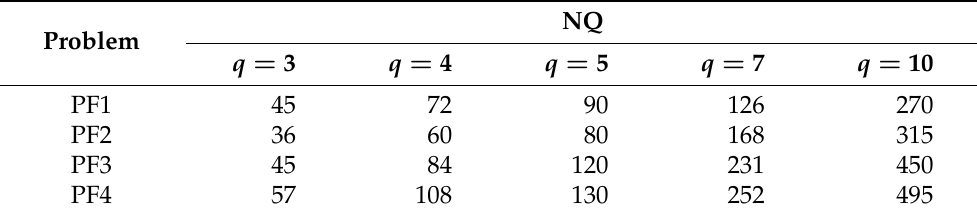
Table 4. NQ needed for each decision problem, varying the parameter q until achieving the stop condition.